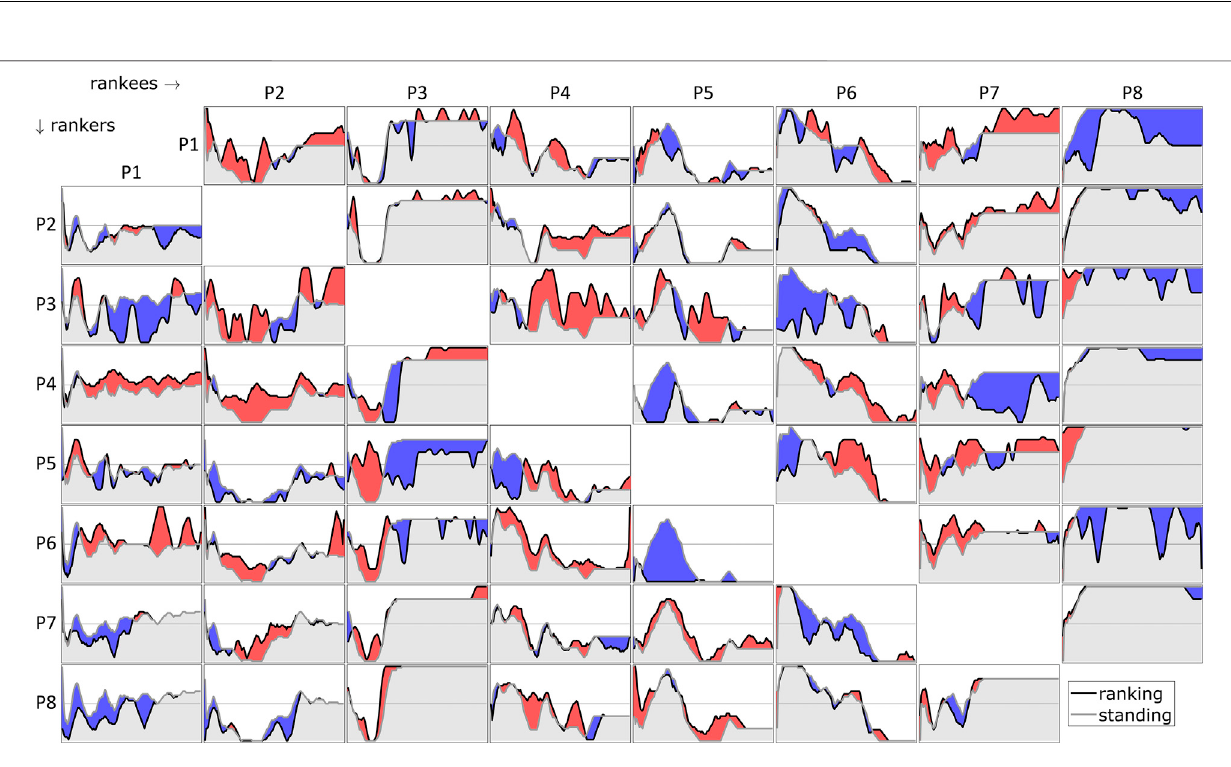
Frontiers in Physics |